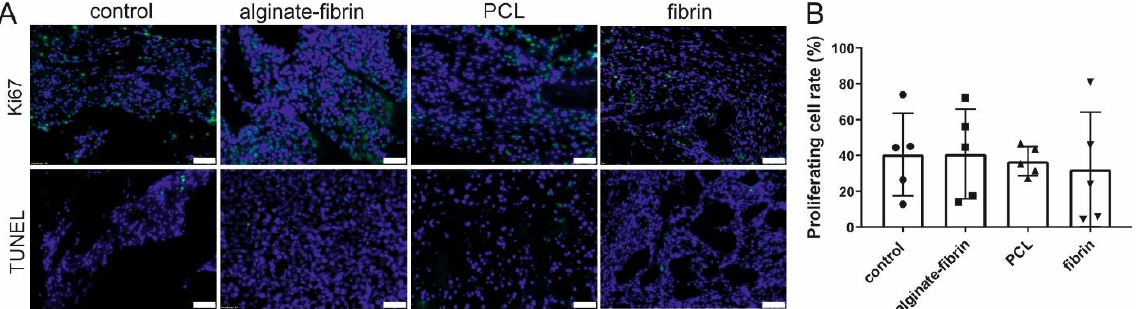
Figure 6. Proliferation and apoptosis in the constructs. ( A ) Representative images of Ki67 and TUNEL staining to investigate cell proliferation and apoptosis, respectively. ( B ) Quantification of the proliferation rate in different constructs. Scale bar 100 μm.